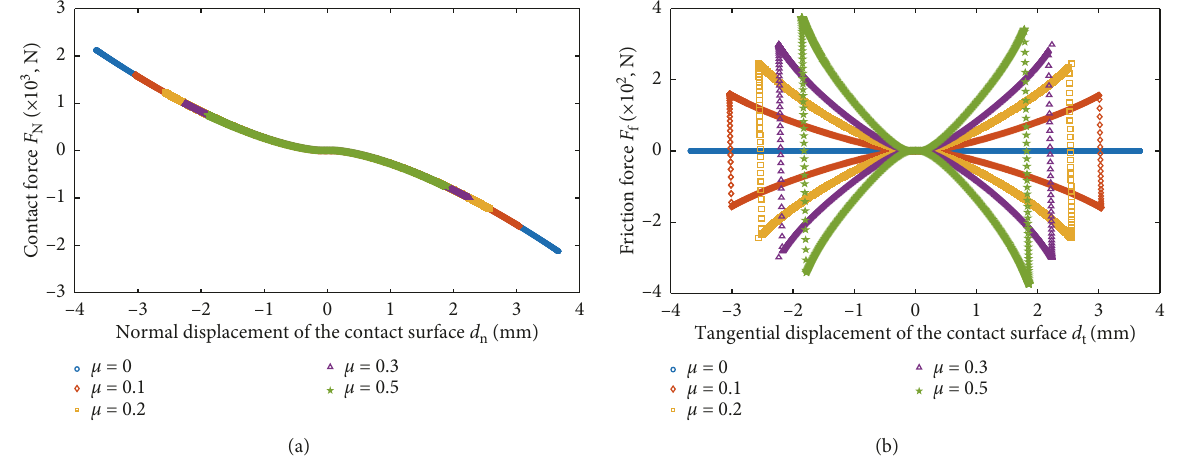
Figure 11: The curves of force at different friction coefficients. (a) Contact forces. (b) Friction